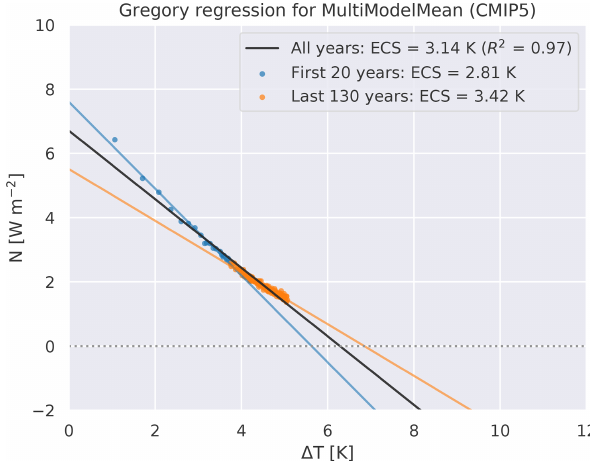
Figure 3. Gregory plot to approximate the ECS (Gregory et al., 2004). Shown is the relationship between the differences in global and annual mean top-of-the-atmosphere net downward radiative flux N (Wm − 2 ) and global and annual mean near-surface air tem- perature anomalies (cid:49)T (K) for the CMIP5 multi-model mean. Anomalies are calculated as difference between the abrupt4xCO2 experiment (quadrupling of CO 2 ) and the pre-industrial control run (piControl). The blue dots show the first 20 years of the simulation; the orange dots show the last 130 years. A linear regression using only the first 20 years (blue line) instead of all 150 years (black line) results in a stronger feedback (and thus lower ECS). Using the last 130 years only (orange line) results in a weaker feedback (i.e., higher ECS). See Sect. 3.2 for details on recipe_ecs.yml